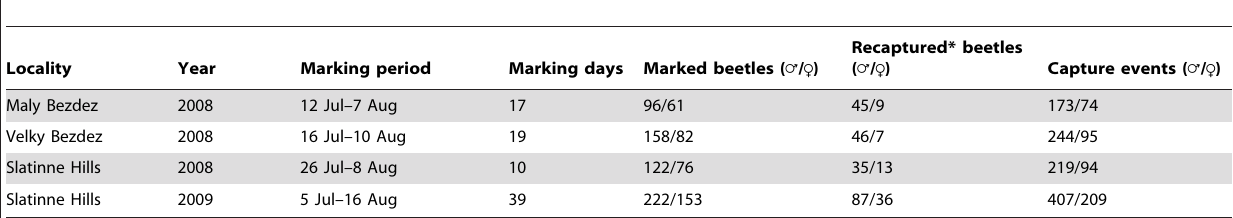
Table 1. Summary of mark-recapture data obtained during the study of the Rosalia longicorn population in the Ralska Upland, Czech